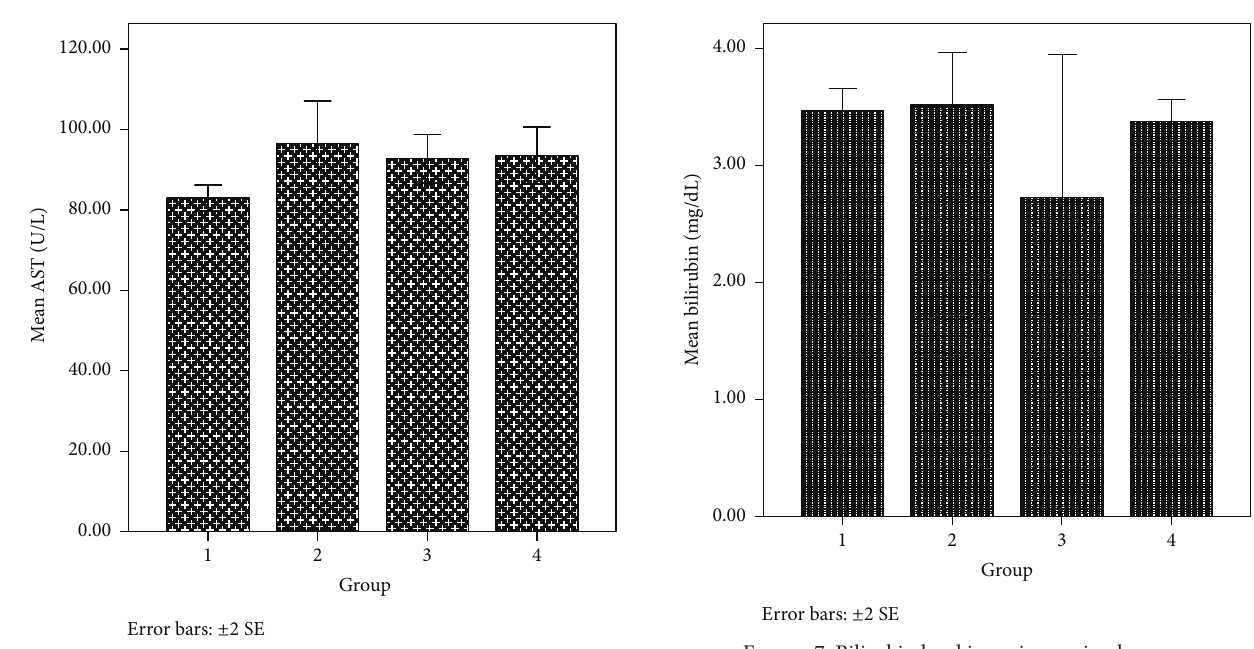
Figure 6: AST level in various animal groups.